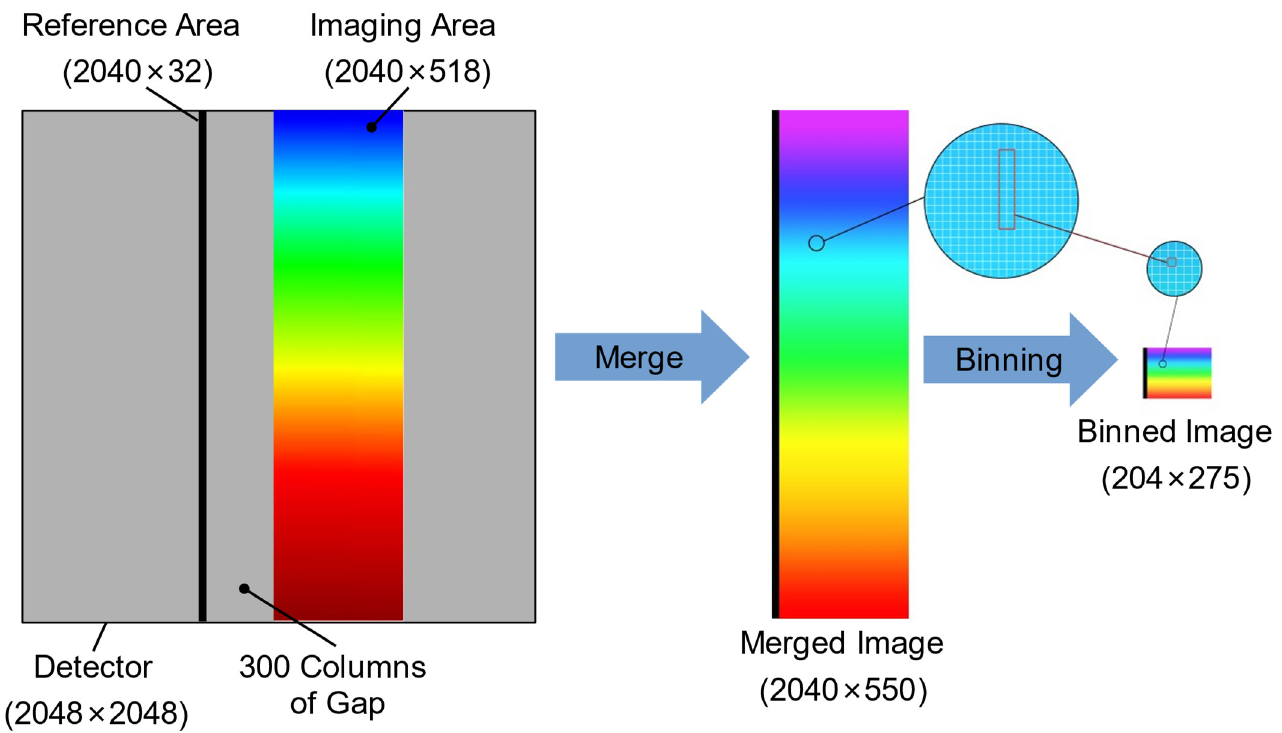
Figure 2. Image transmission process for HARIS.